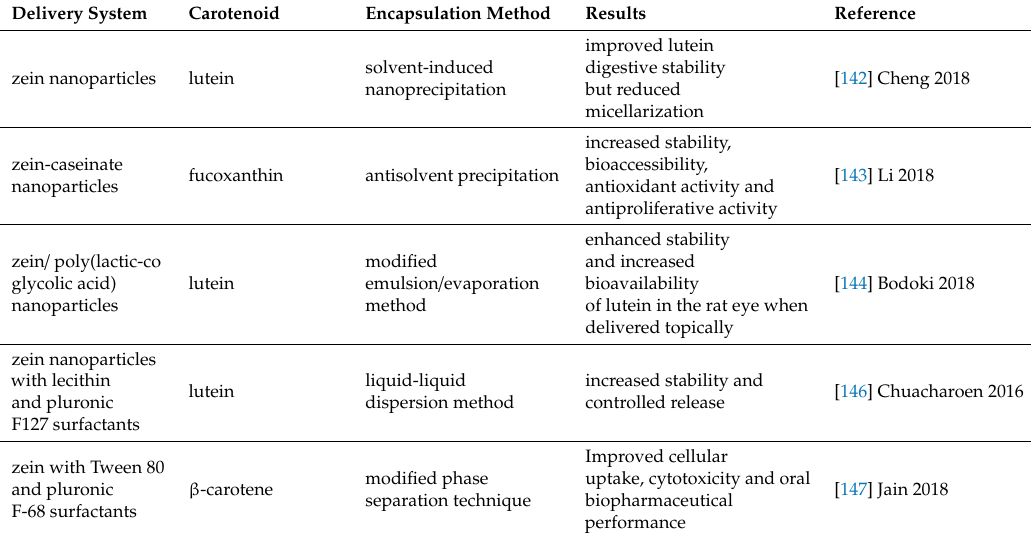
Table 8. Polymeric nanoparticles as delivery system for carotenoid encapsulation: zein